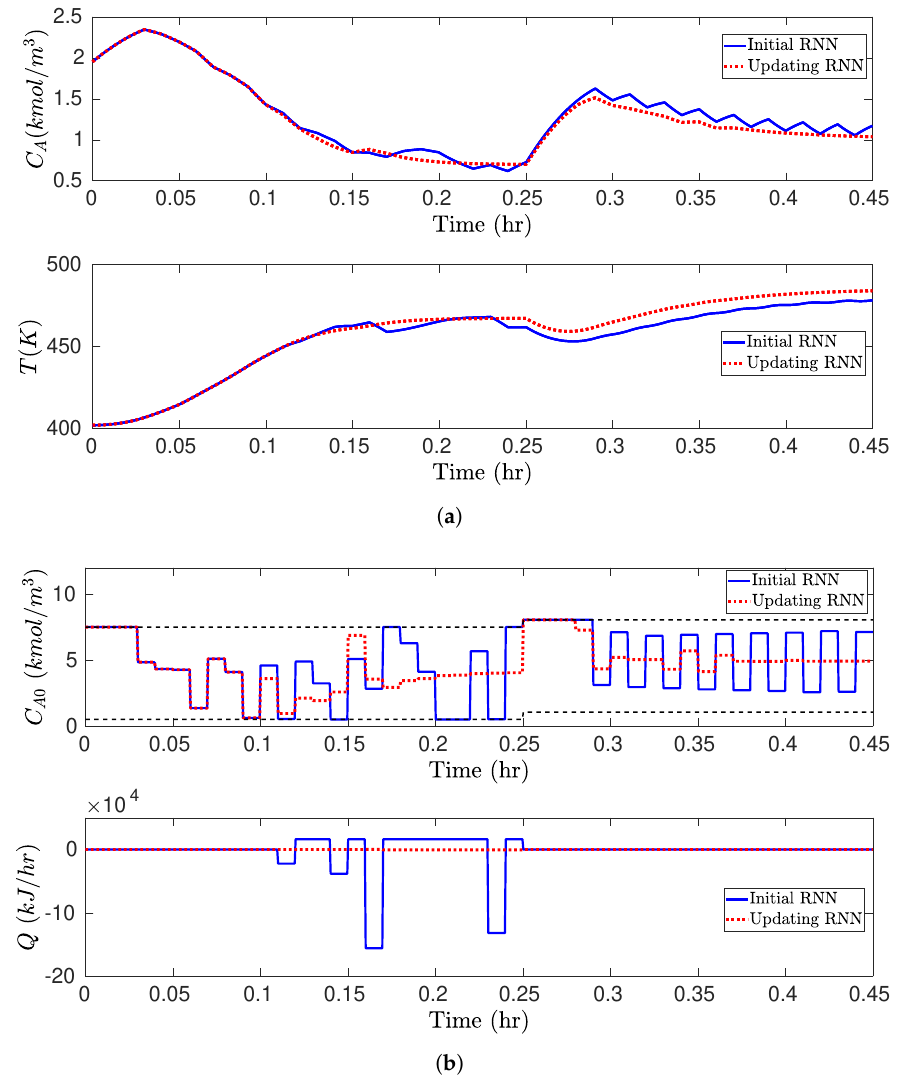
Figure 4. ( a ) Closed-loop state ( C A and T ) and ( b ) manipulated input ( C A uncertain CSTR system operating in mode 1 for t ∈ [ 0, 0.25 h) and switching to mode 2 at t = 0.25 h under the RNN-LEMPC of Equation (26) using the initial offline-learning RNNs at all times (blue solid line), and using the online updating RNNs (red dashed line), for the initial condition ( C A , T ) = (1.95 kmol/m 3 402